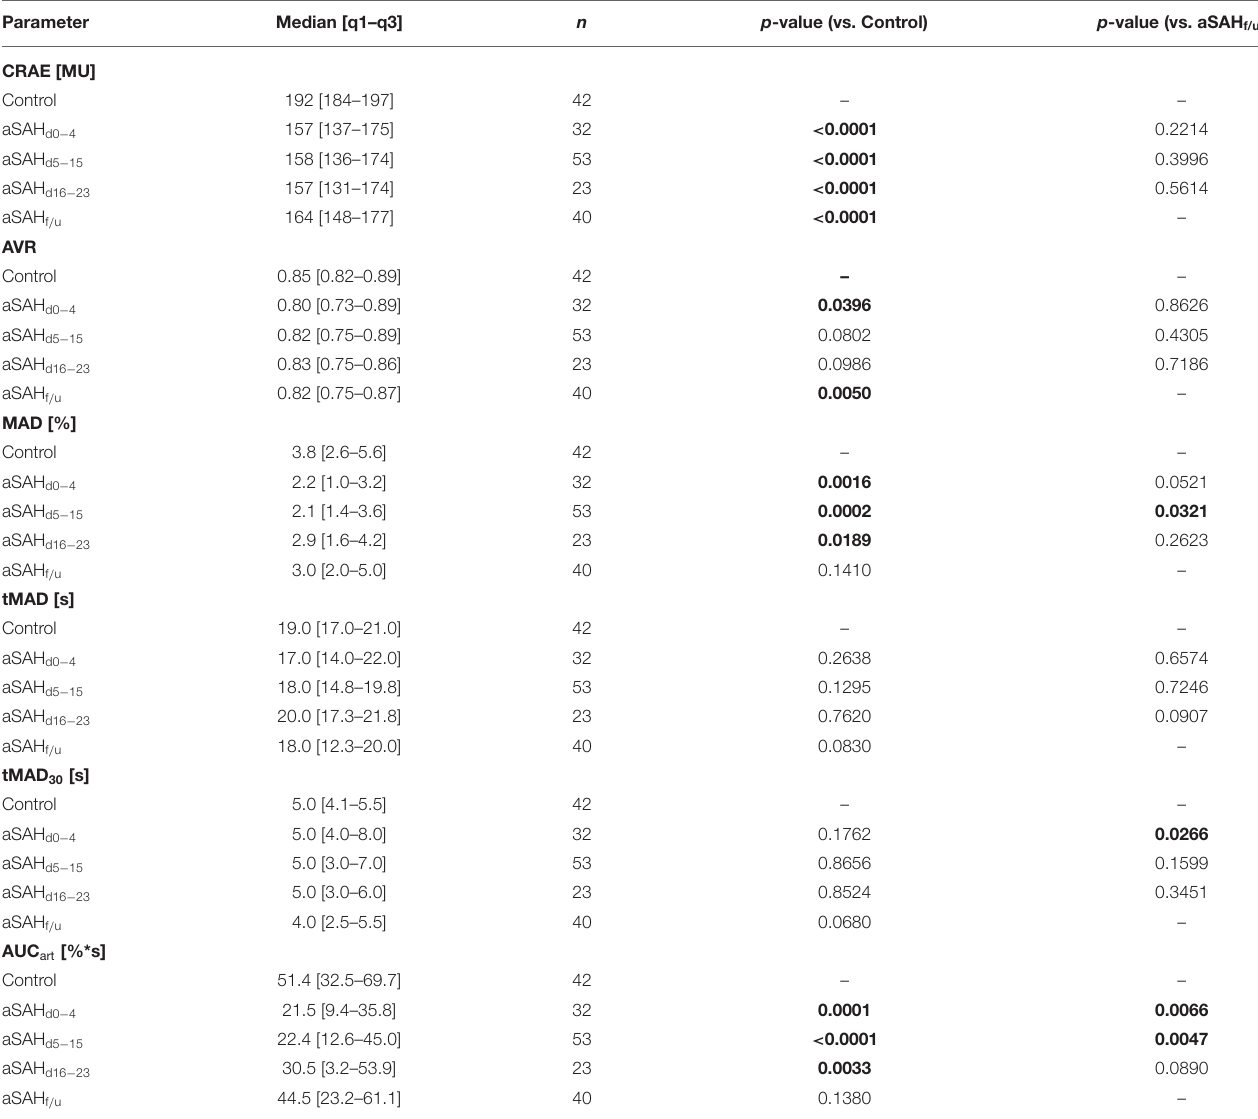
TABLE 2 | Arterial RVA parameters in control and aSAH patients. Parameter Median [q1–q3] n p -value (vs. Control) p -value (vs. aSAH f/u